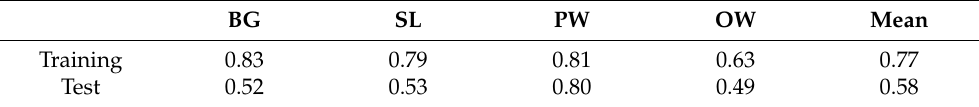
Table 17. IoU scores for Soybeans in Experiment C.